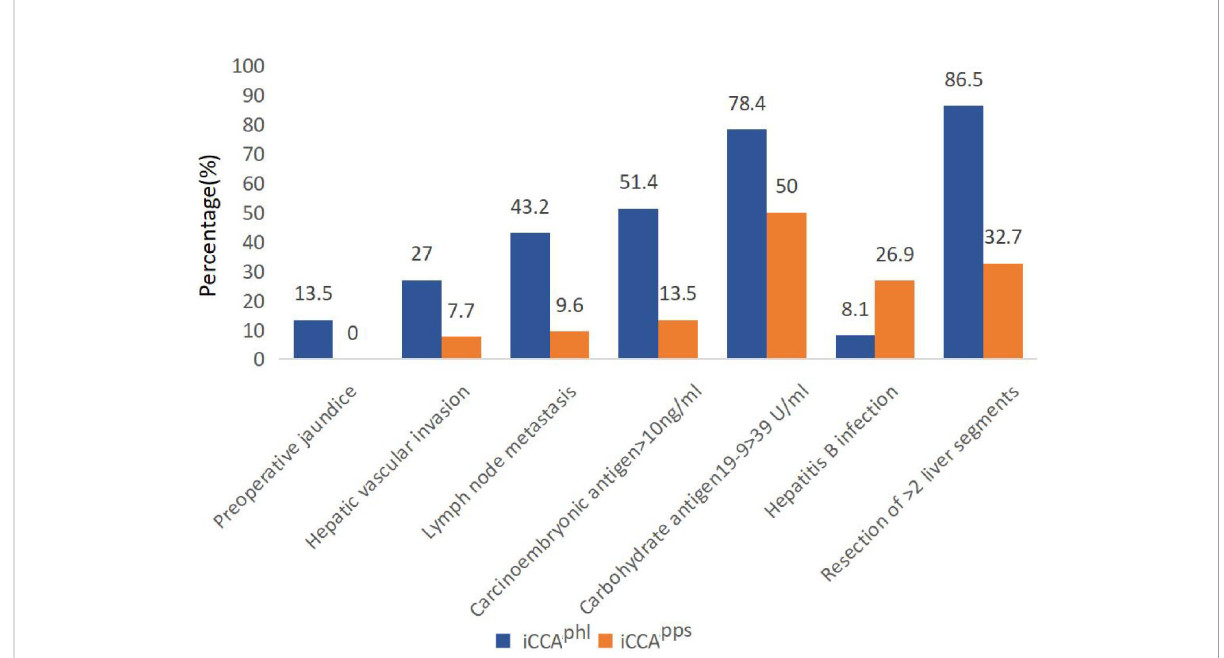
FIGURE 2 Pairwise comparison of the two types of intrahepatic cholangiocarcinoma (P < 0.05). The bars in the graph indicate the number of cases in each group for each risk factor. iCCA phl , perihilar large duct type of intrahepatic cholangiocarcinoma; iCCA pps , peripheral small duct type of intrahepatic